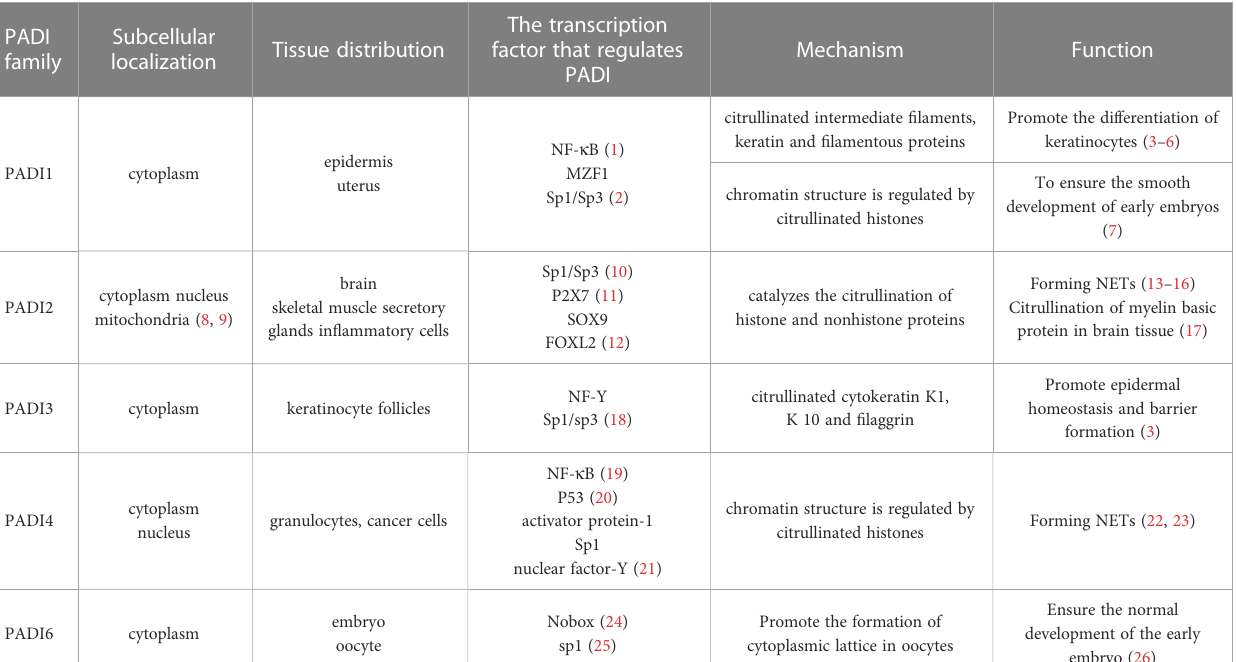
TABLE 1 Distribution and function of PADI family members.